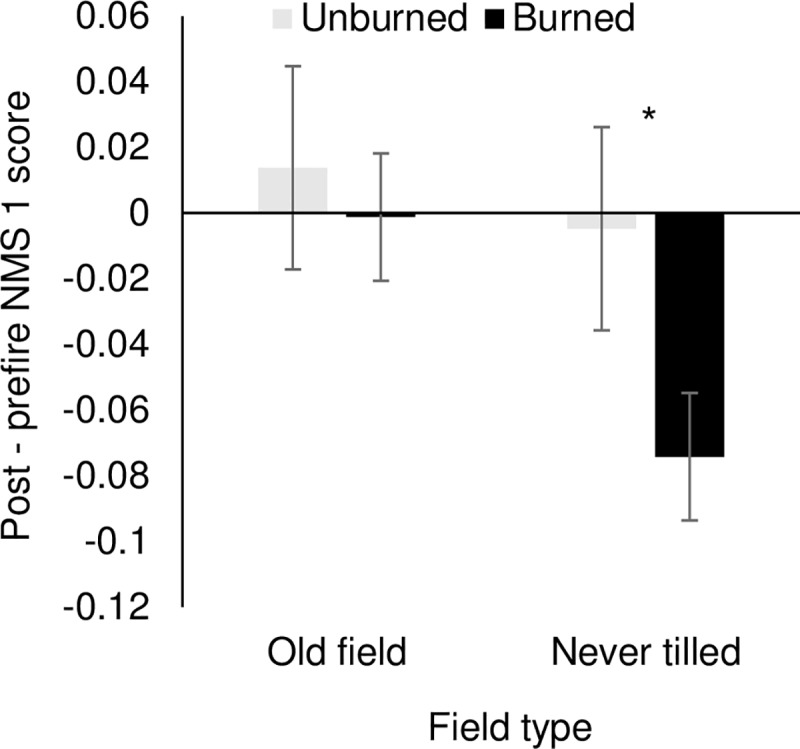
Change in NMS axis 1 values after a wildfire in 2014.Values calculated as the difference between 2015 scores and the average of 2002 to 2014 values. Negative post-prefire NMS scores indicate increased weediness. An asterisk indicates a difference between Unburned and Burned values at the α = 0.05 level.